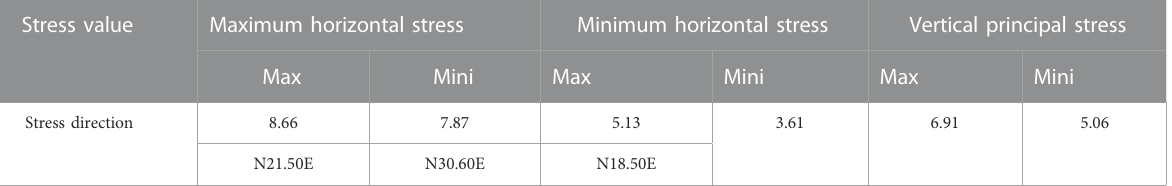
TABLE 2 Strength test parameters for surrounding of No. 15 coal roof.